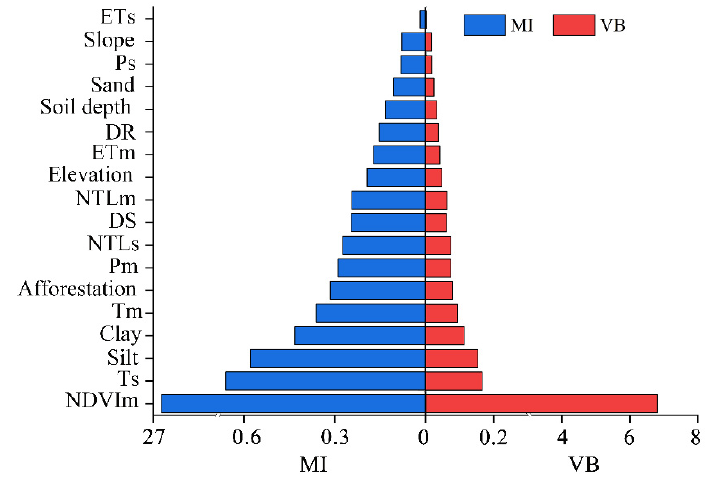
Figure 8. Sensitivity analysis of the driving factors.